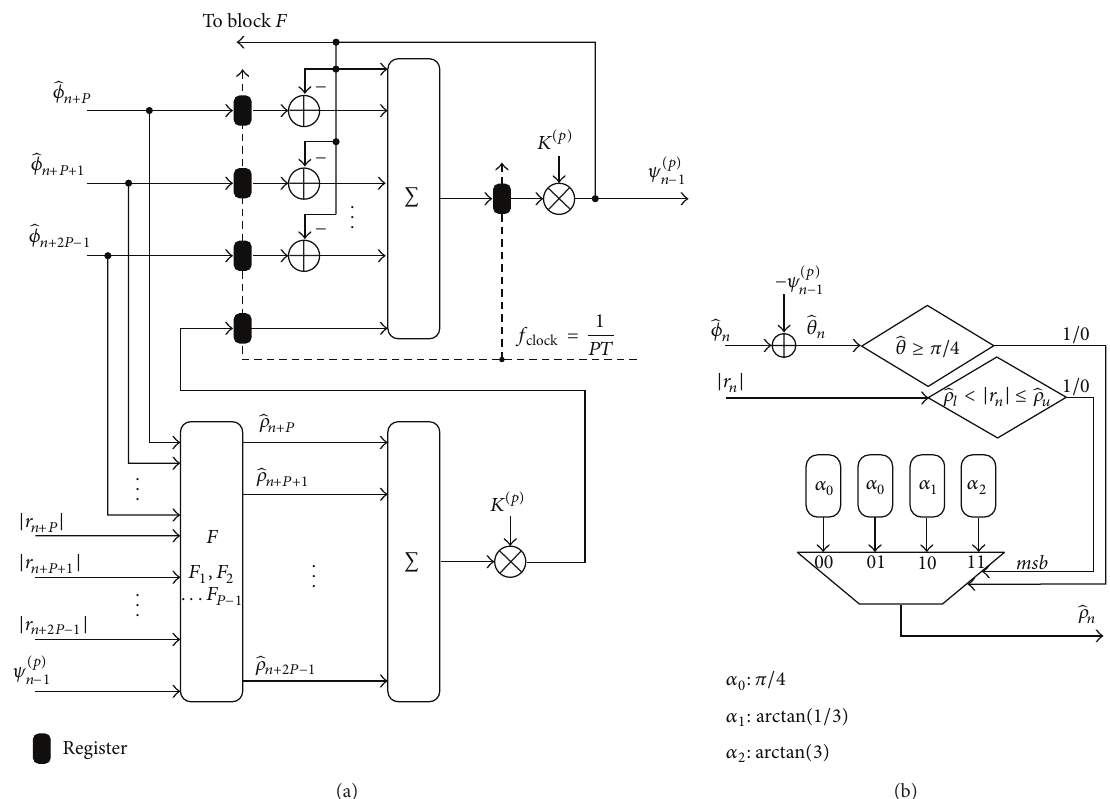
Figure 16: Block diagram of the implementation of (a) “ 𝑊 𝑃−1 ” module and (b) block “ 𝐹 𝑘 ” for 16-QAM.